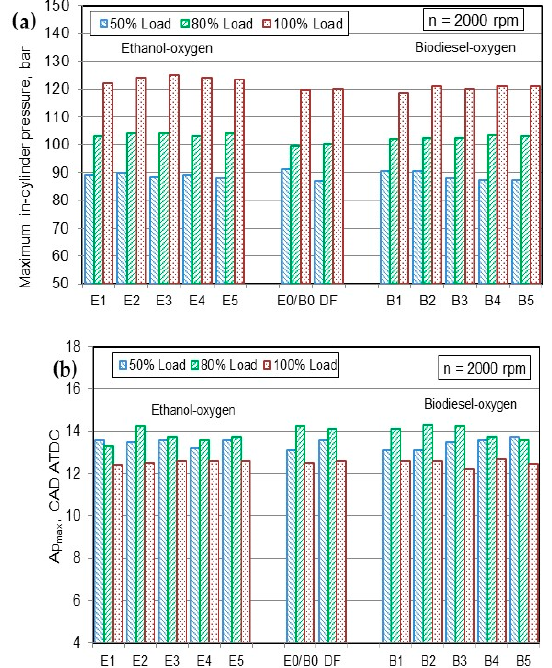
Figure 8. Maximum in-cylinder pressure p max ( a ) and its location angle ∆ p max ATDC ( b ) as a function of ethanol–oxygen or biodiesel-oxygen mass content (wt%) in fuel blends for medium (50%), intermediate (80%), and full (100%) loads corresponding to respective IMEPs of 0.75, 1.20, and 1.50 MPa, developed at a speed of 2000 rpm.